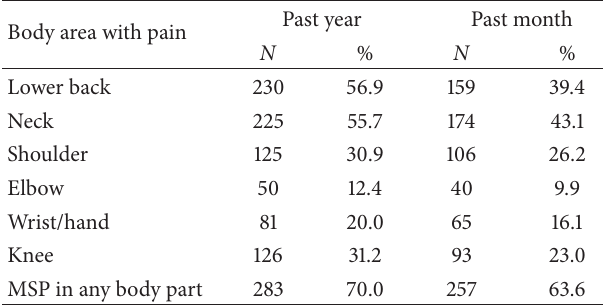
Table3:Prevalenceofmusculoskeletalpaininthepastyearandpast